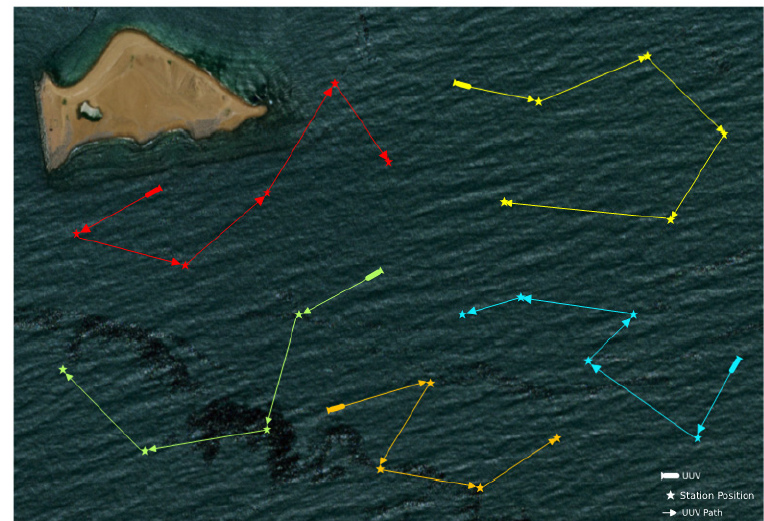
Figure 2. Diagram of a UUV swarm visiting multiple underwater stations.